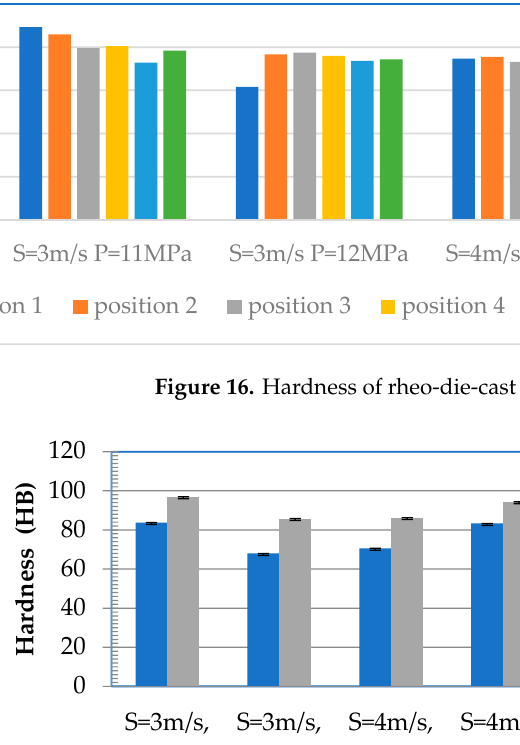
Figure 16. Hardness of rheo - die-cast bars .